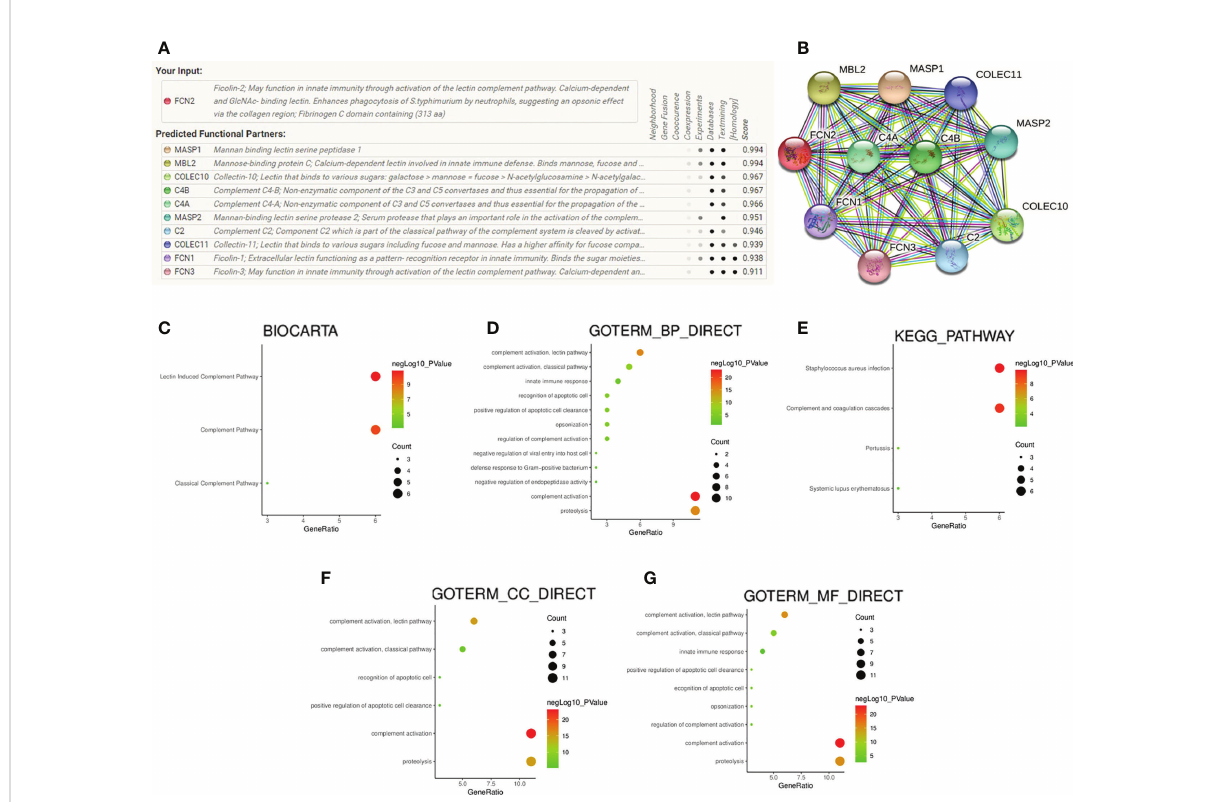
FIGURE 8 Protein – protein interaction network analysis and enrichment analysis. (A, B) Gene network diagram of interaction with FCN2 created using the STRING database. (C – G) Diagrams of the analyses of the Kyoto Encyclopedia of Genes and Genomes (KEGG) and Gene Ontology (GO)